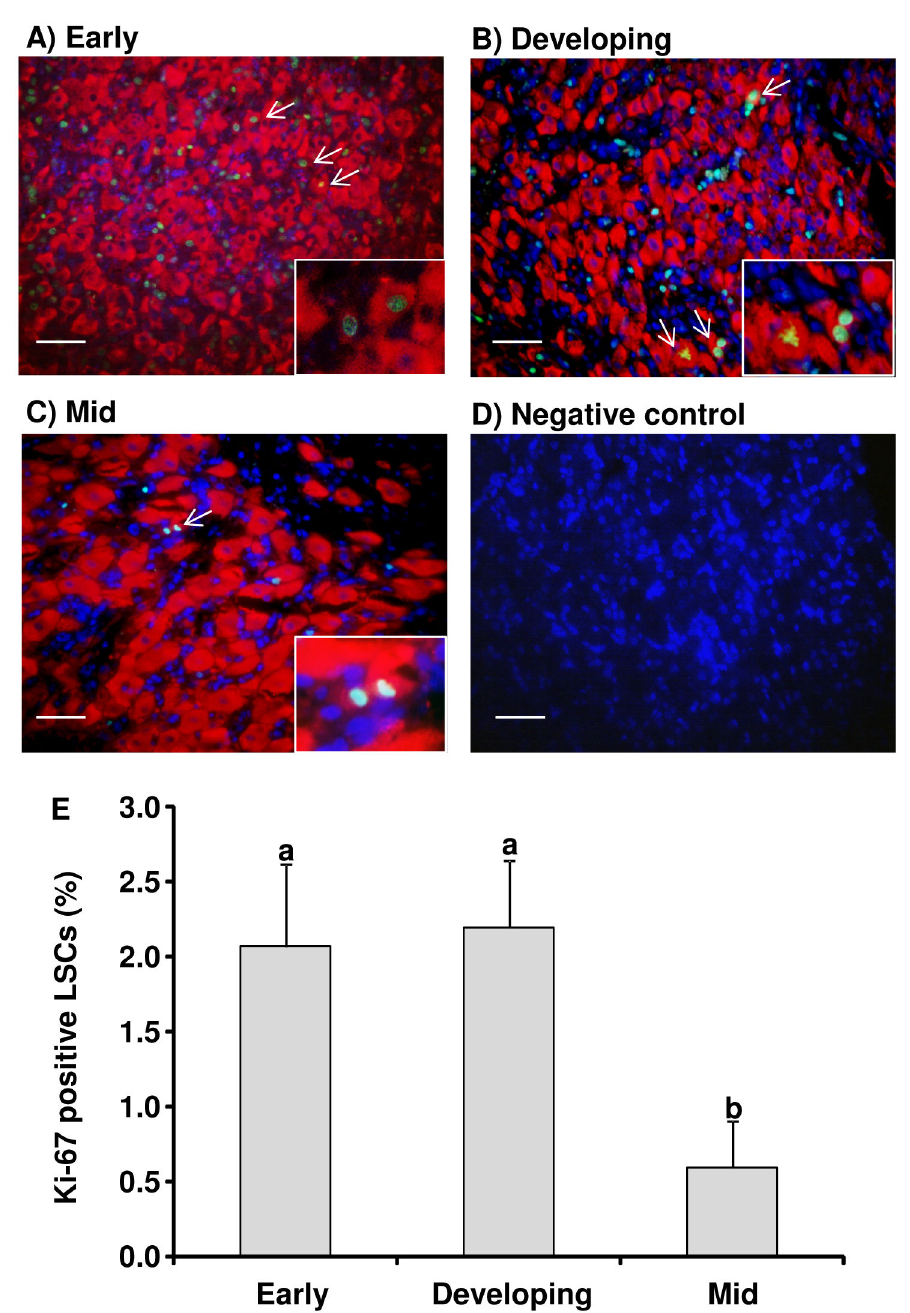
Figure 2. KI-67 and HSD3B expression in the bovine CL. Representative images of double-immunohistochemical staining for KI-67 and HSD3B in early (A), developing (B) and mid (C) bovine CL. Normal horse serum was used as a negative control (D). Scale bars represent 50 μm. (E) Percentage of KI-67 positive LSCs in the bovine CL (mean±SEM, n=3 experiments). Percentages in each luteal stage were derived from dividing the number of Ki-67 and HSD3B positive cells by total number of HSD3B positive cells. Cells were counted in three randomly chosen areas. Different superscript letters indicate significant differences (P<0.05).